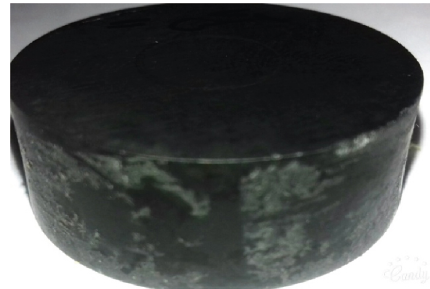
Figure 1: Grade WC-Co-TiC cermet obtained by the sintering process.